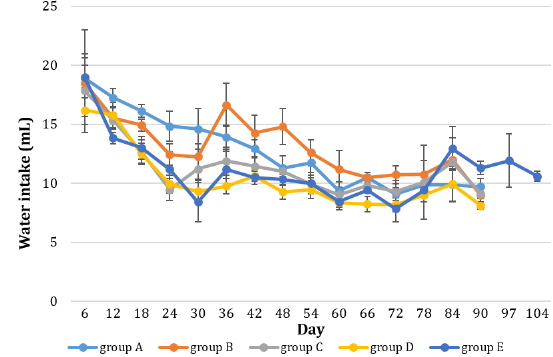
Figure 4. Mean water consumption in mice treated with 14 (group B), 28 (group C), 56 mg/kg/d DPP (group D), and recovery group (group E) as compared to the control group (group A) during sub-chronic toxicity study (P>0.05) (Utami,